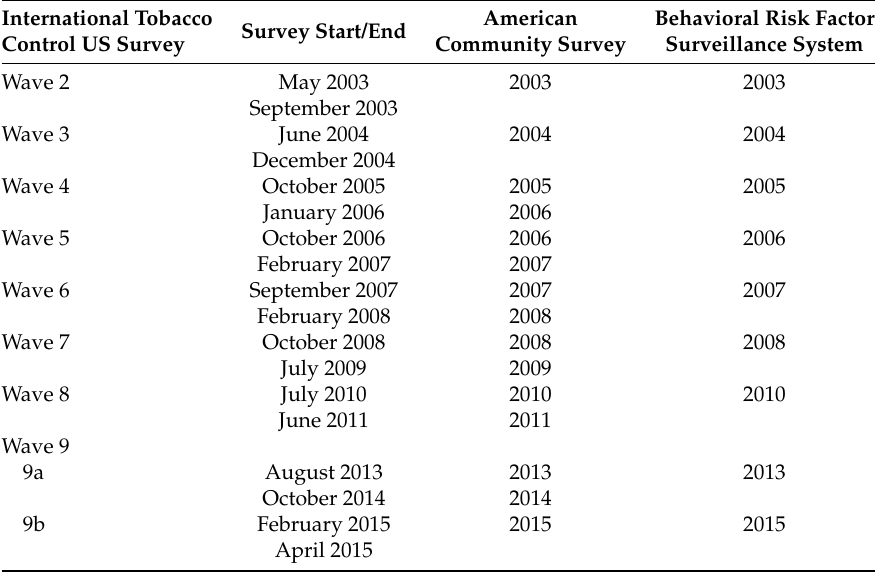
Table 1. Data sources used for state-level estimation of cigarette